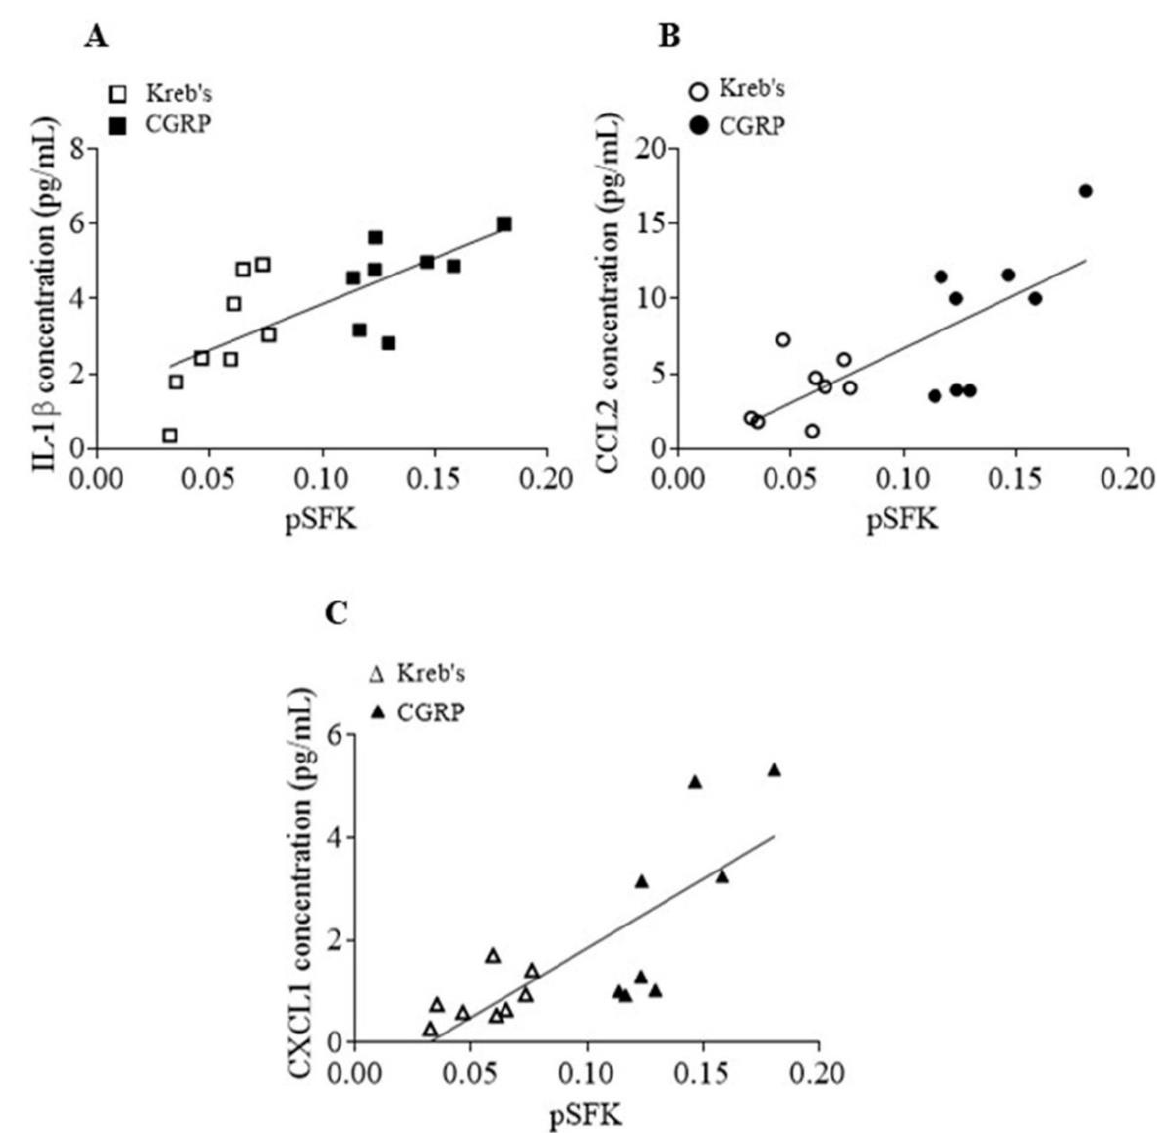
Figure 7. The levels of phosphorylated SFKs at Y416 and released cytokines induced by CGRP were correlated in the mouse TG. Correlation analysis between the levels of phosphorylated SFKs at Y416 and IL-1 β ( A ), CCL2 ( B ), CXCL1 ( C ) release in the mouse TG treated by Kreb’s and 3 µ M CGRP ( n = 8 per group) for 20 minutes.